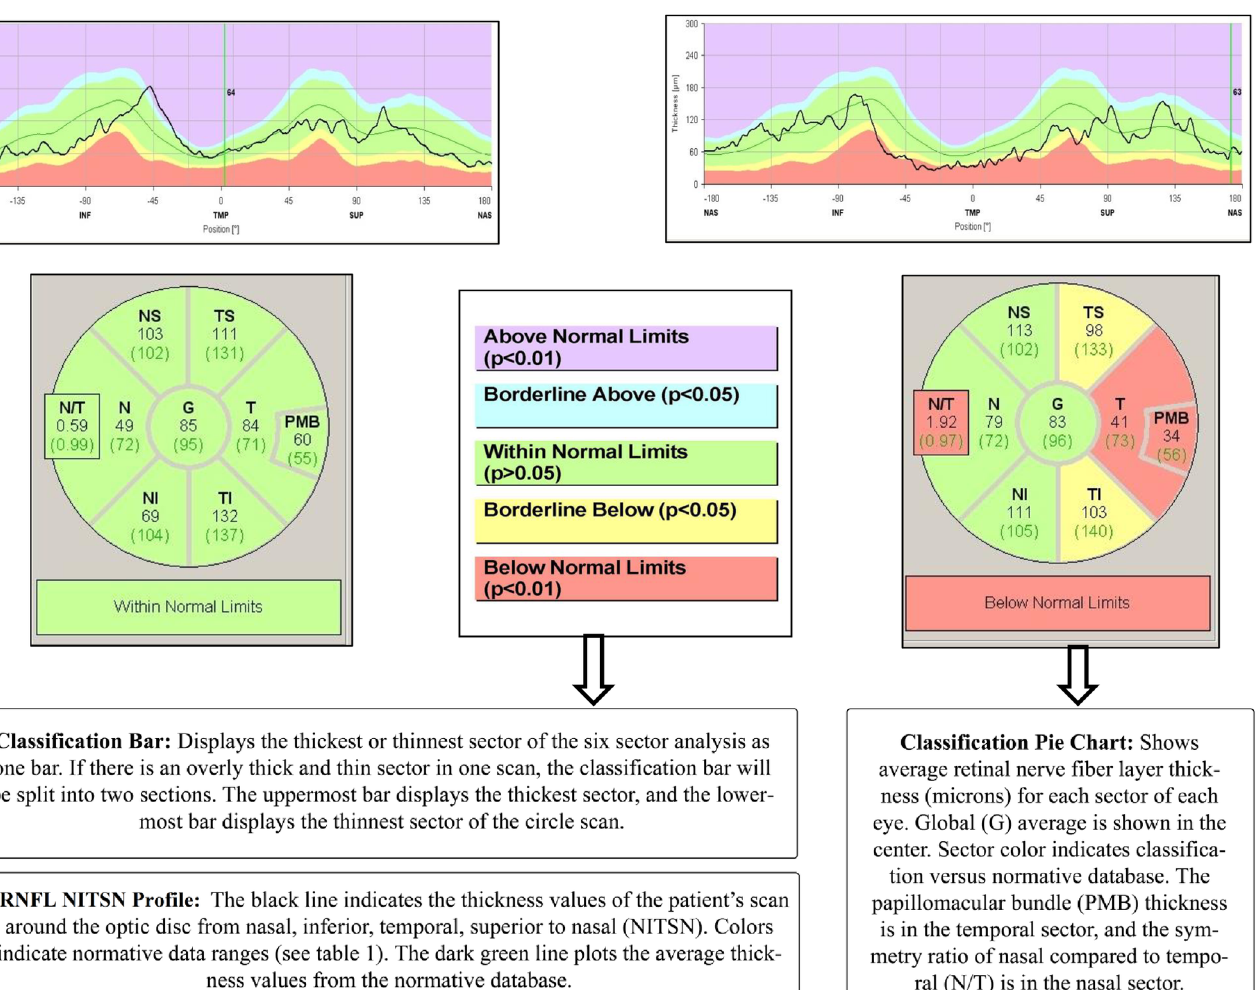
Fig 1. Representation and interpretation of the report from the Axonal application of the Spectralis optical coherence tomography in a control (left side) and in a patient with fibromyalgia and retina nerve fiber layer thinning (right side).